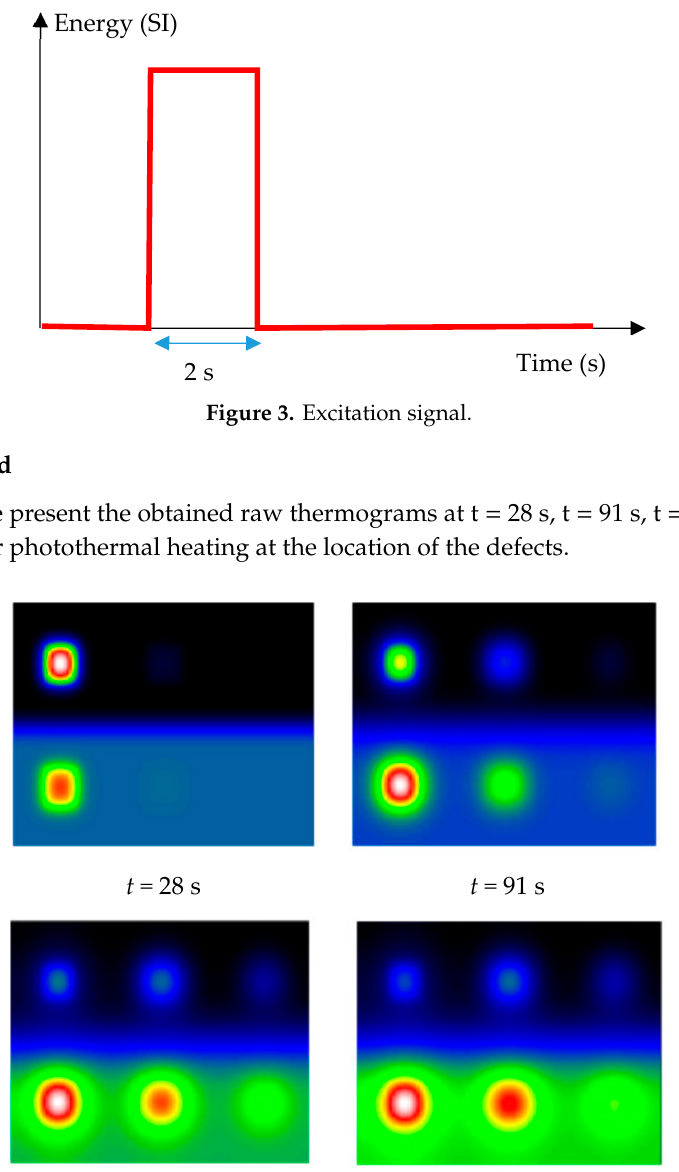
Figure 4. Example of theoretical thermograms obtained (t = 28 s, t = 91 s, t = 177 s and t = 200 s).